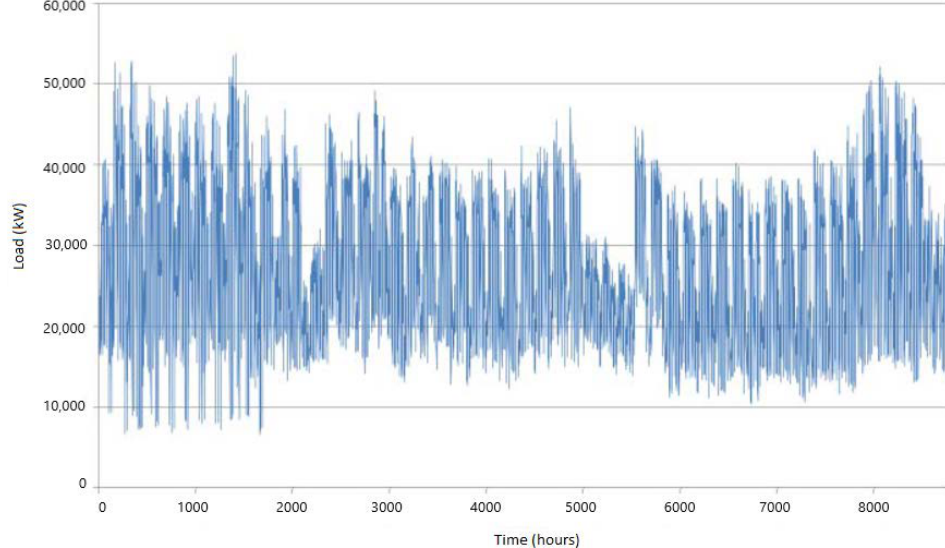
Figure 8. Demand pattern for industrial areas used in this study.